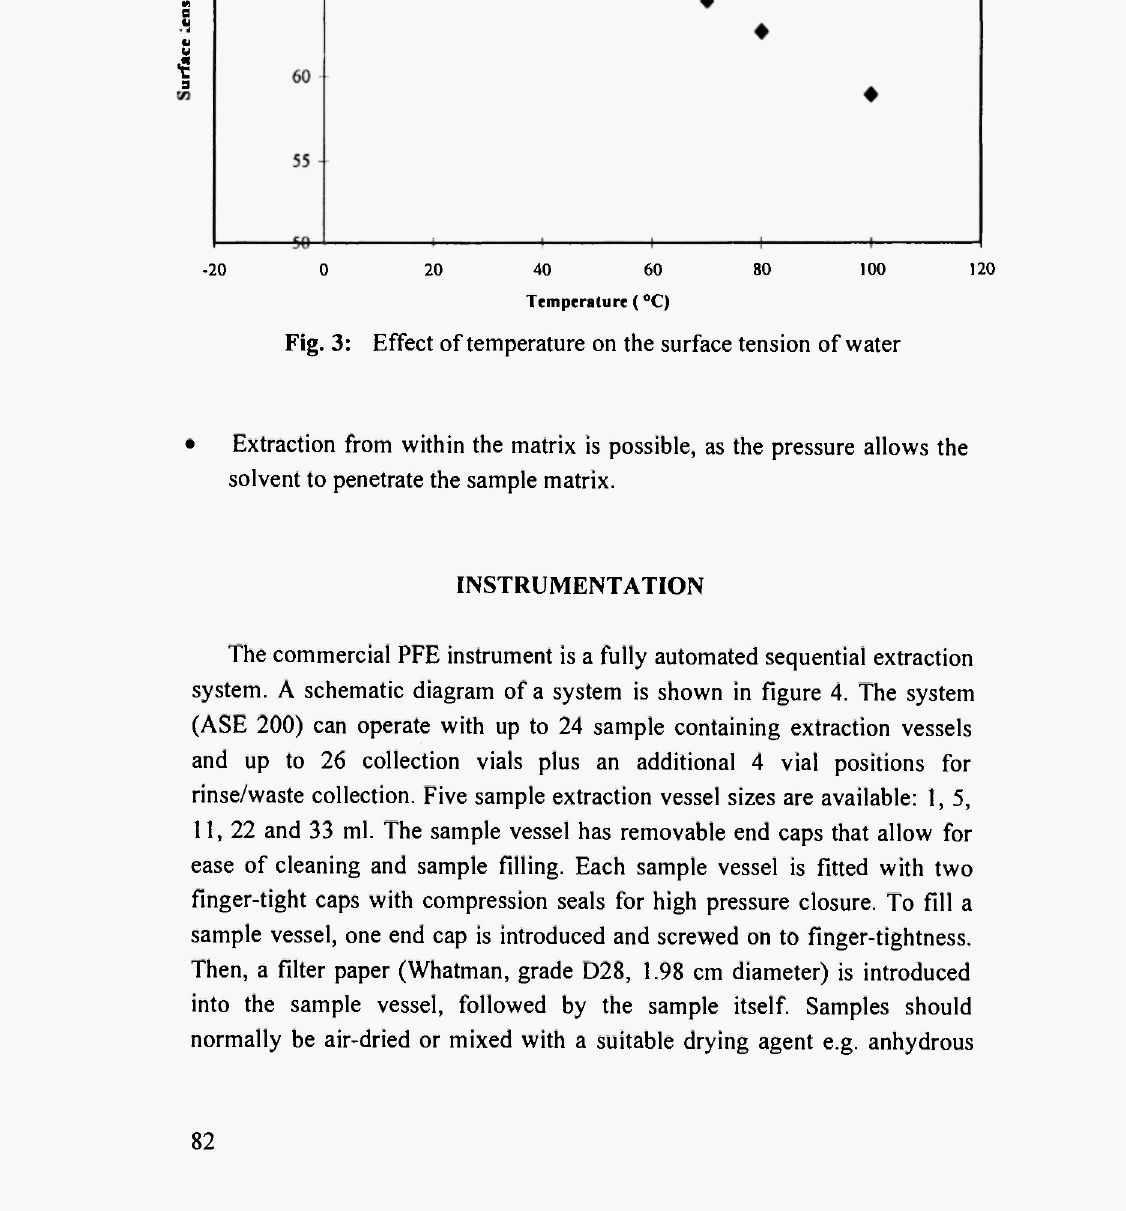
Fig. 3: Effect of temperature on the surface tension of